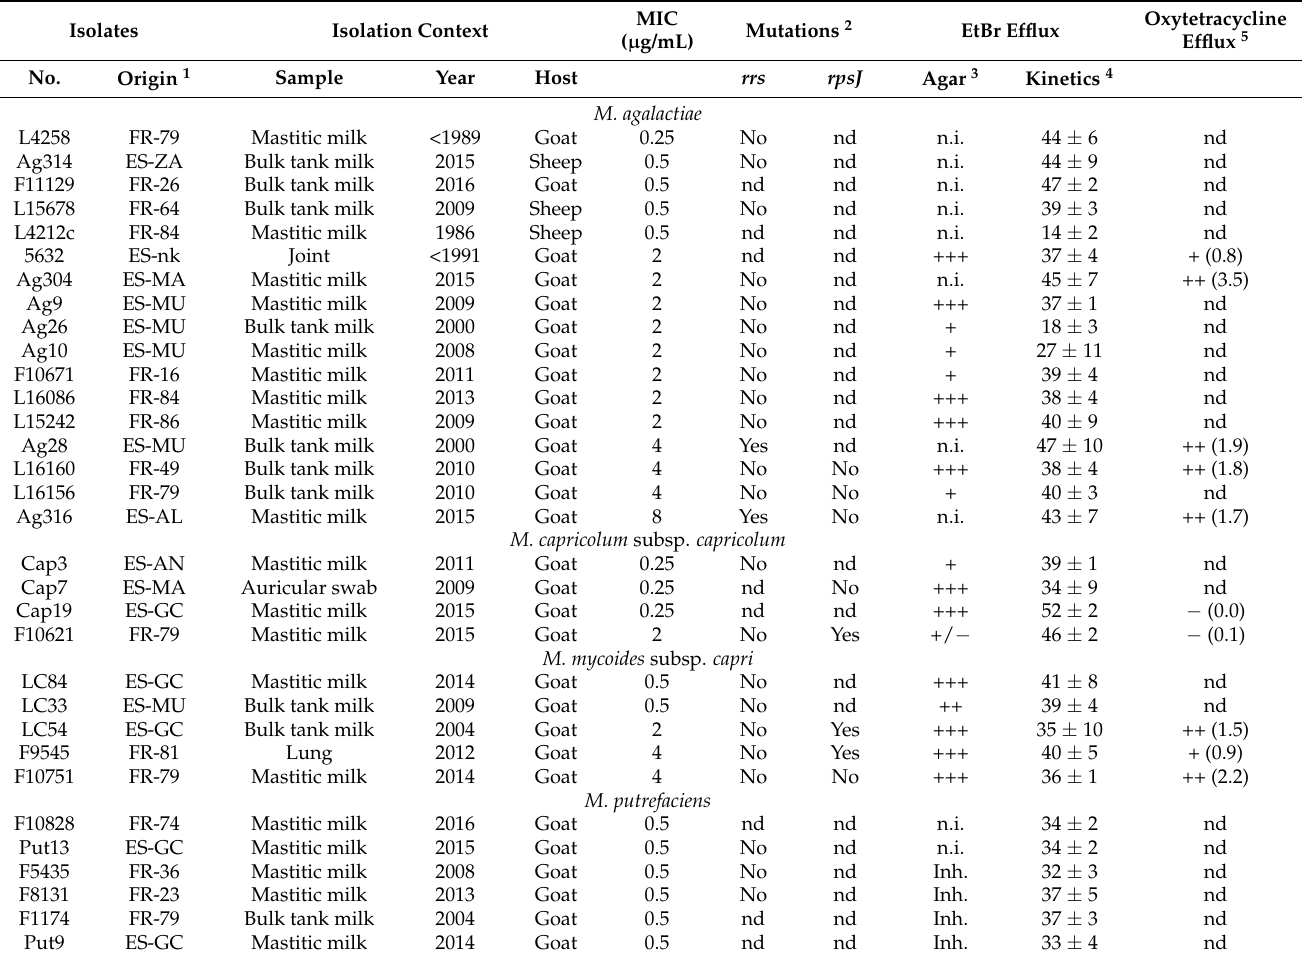
Table 1. The 32 mycoplasma isolates included in the study and details of their origin, oxytetracycline MICs, rrs / rpsJ genotype when available, and results obtained in the different experiments described in this